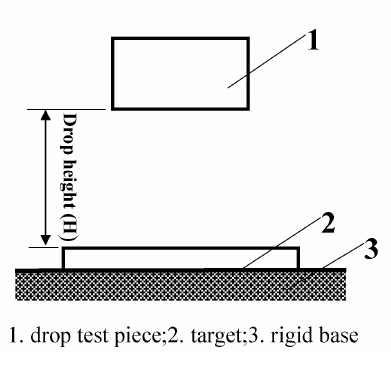
Figure 1. Diagram of the drop